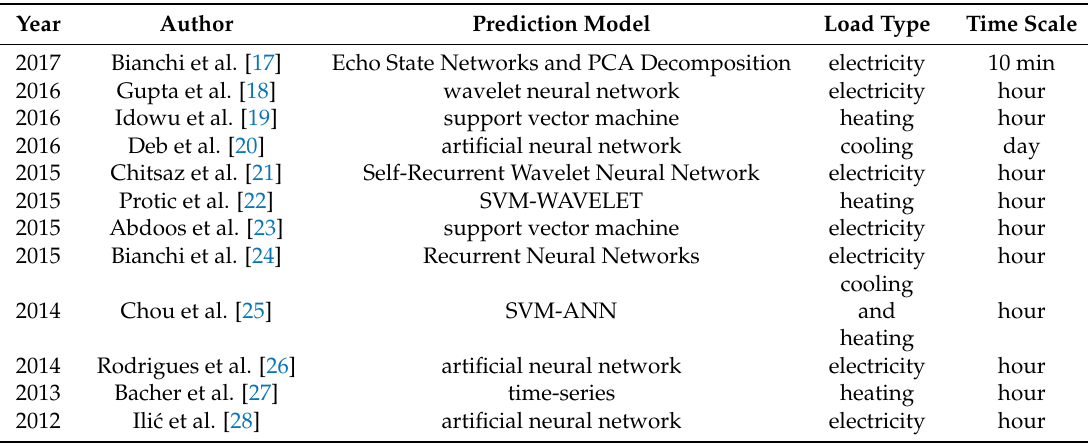
Table 2. Summary on load forecast research from exiting